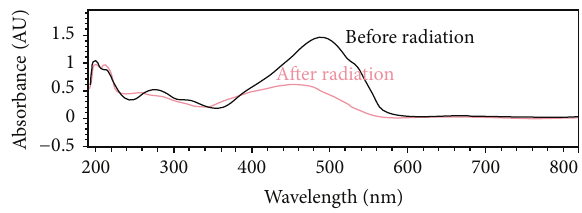
Figure 16: Absorbance curves of MO aqueous solution in the presence of the anatase membrane before and after UV radiation.